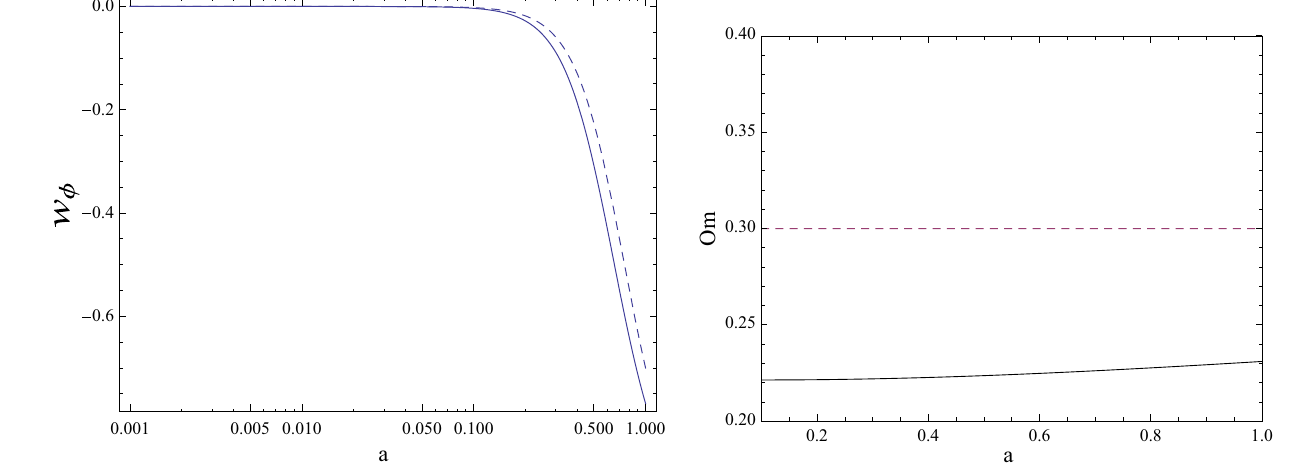
= 10 − 6 . Right The behaviour of the Om parameter. The solid and σ i dashed lines represent the same models as in the left